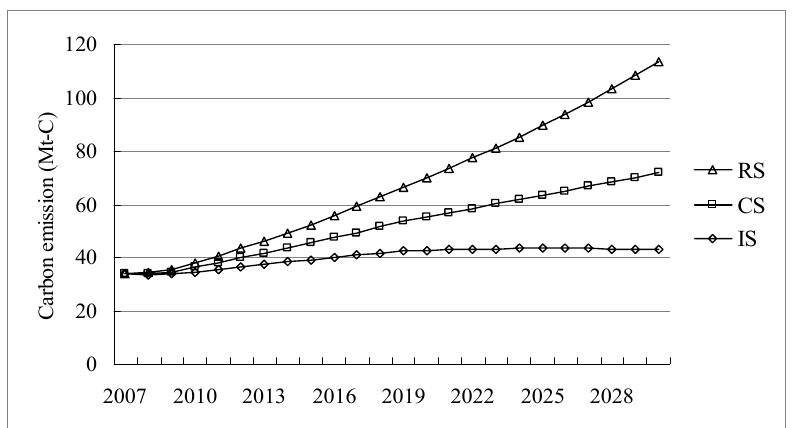
Figure 3. Carbon emissions under the three scenarios from 2007 to 2030.